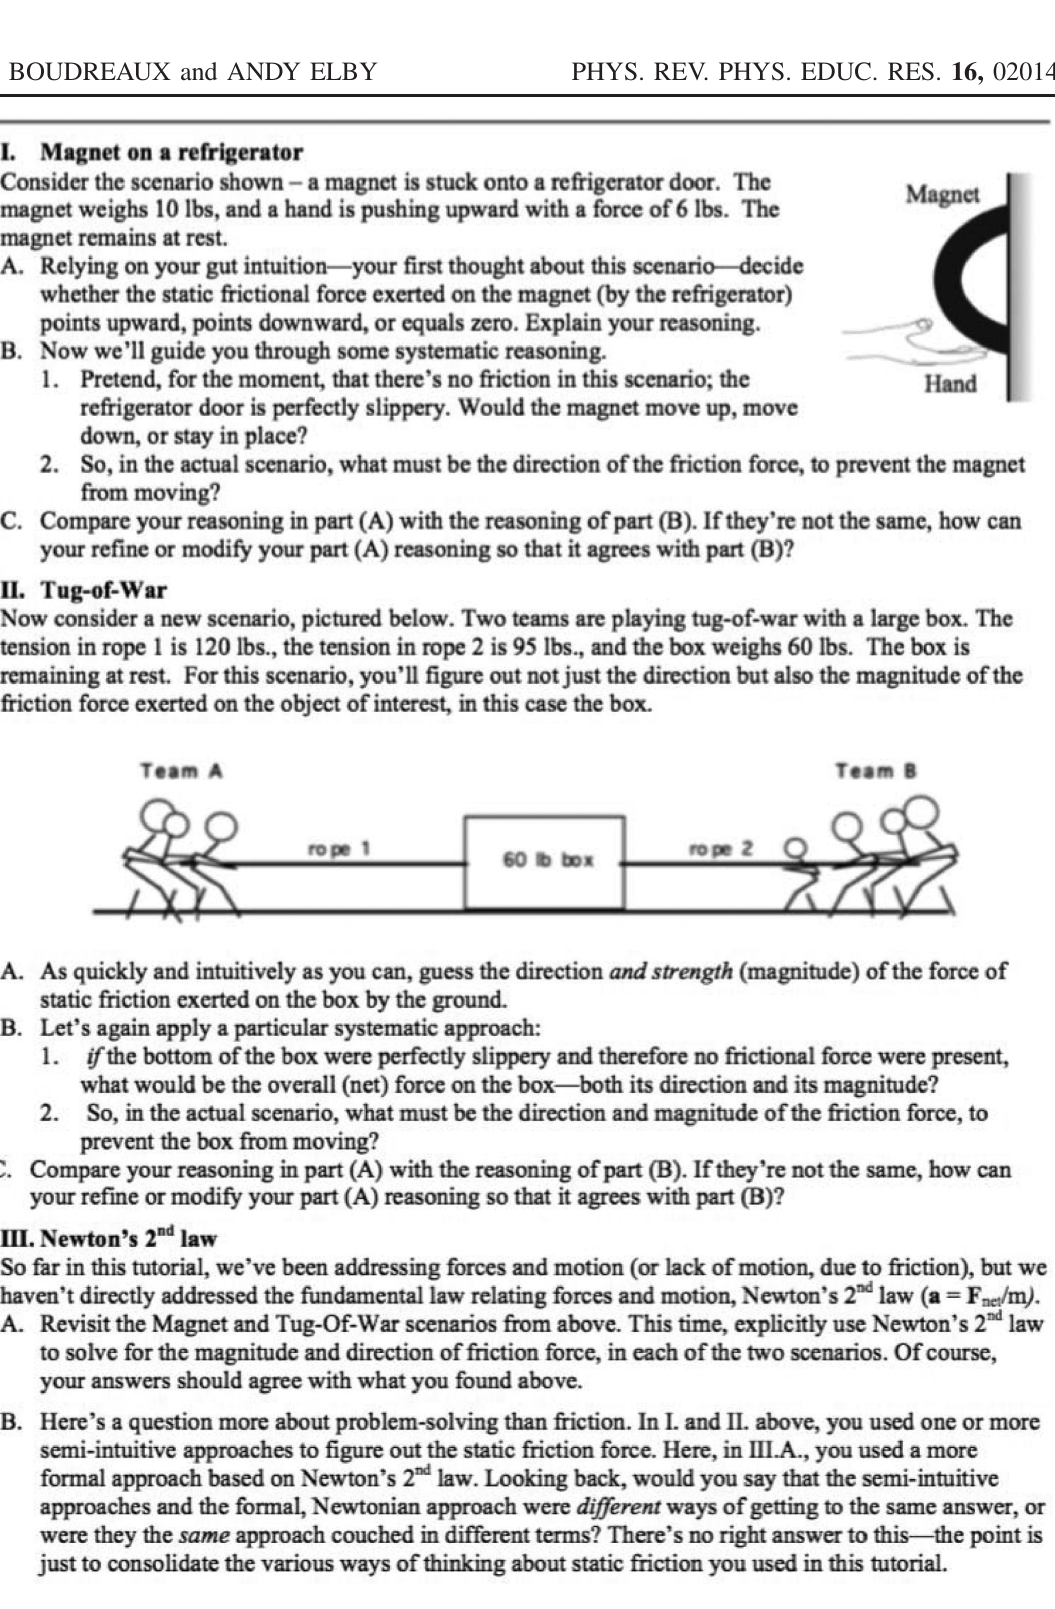
FIG. 4. Draft of Andy ’ s static friction tutorial based on the resources